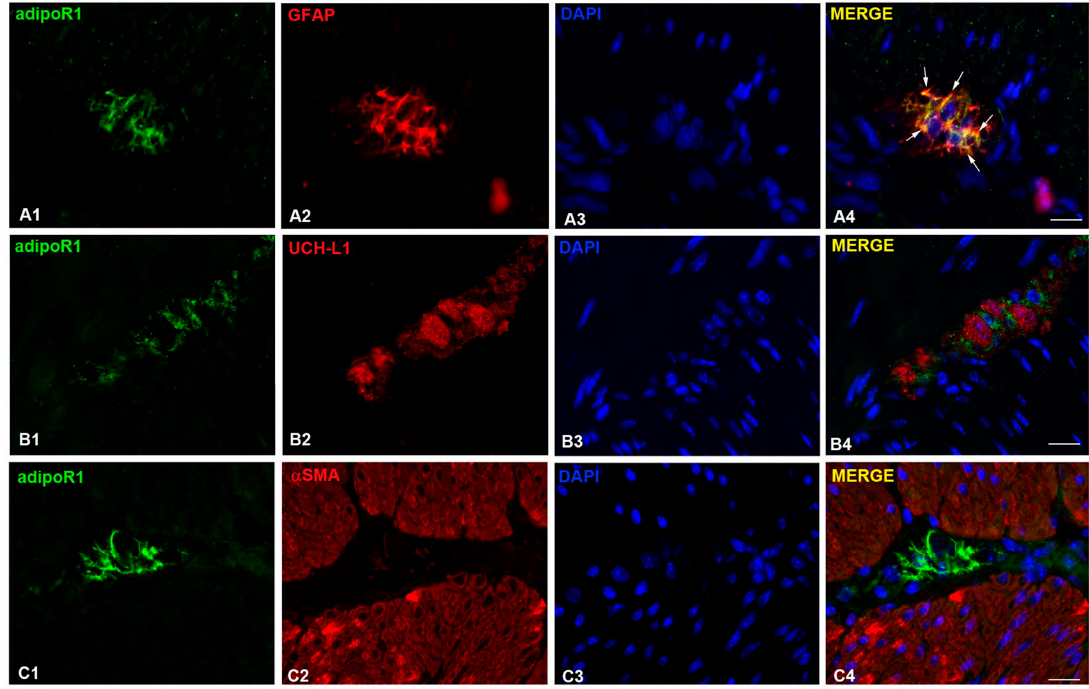
Figure 8. Localization of AdipoR1 in the gastric fundus. Representative photomicrographs of gastric tissue showing double immunofluorescence labeling. ( A1–A4 ) Co-localization of adipoR1 and GFAP: ( A1 ) adipoR1 signal (green channel); ( A2 ) GFAP signal (red channel); ( A3 ) DAPI; ( A4 ) merged images. ( B1–B4 ) Co-localization of adipoR1 and UCH-L1: ( B1 ) adipoR1 signal (green channel); ( B2 ) UCH-L1signal (red channel); ( B3 ) DAPI; ( B4 ) merged images. ( C1–C4 ) Co-localization of adipoR1 and α SMA; ( C1 ) adipoR1 signal (green channel); ( C2 ) α SMA signal (red channel); ( C3 ) DAPI; ( C4 ) merged images. Scale Bars: 10 μ m.